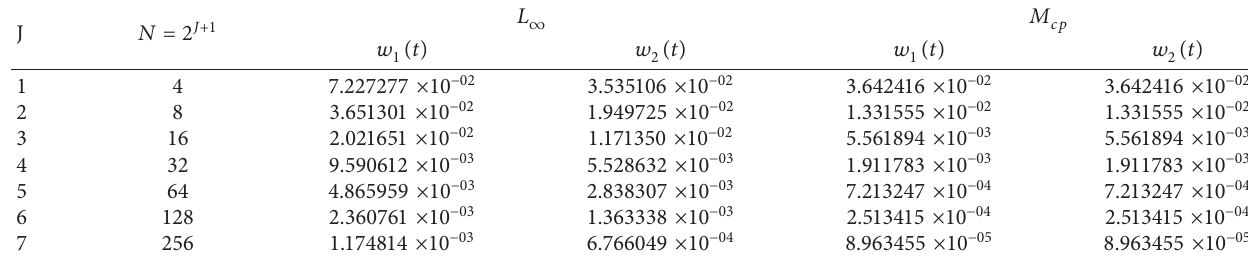
Table 1: L and M cp errors for Problem 1. ∞